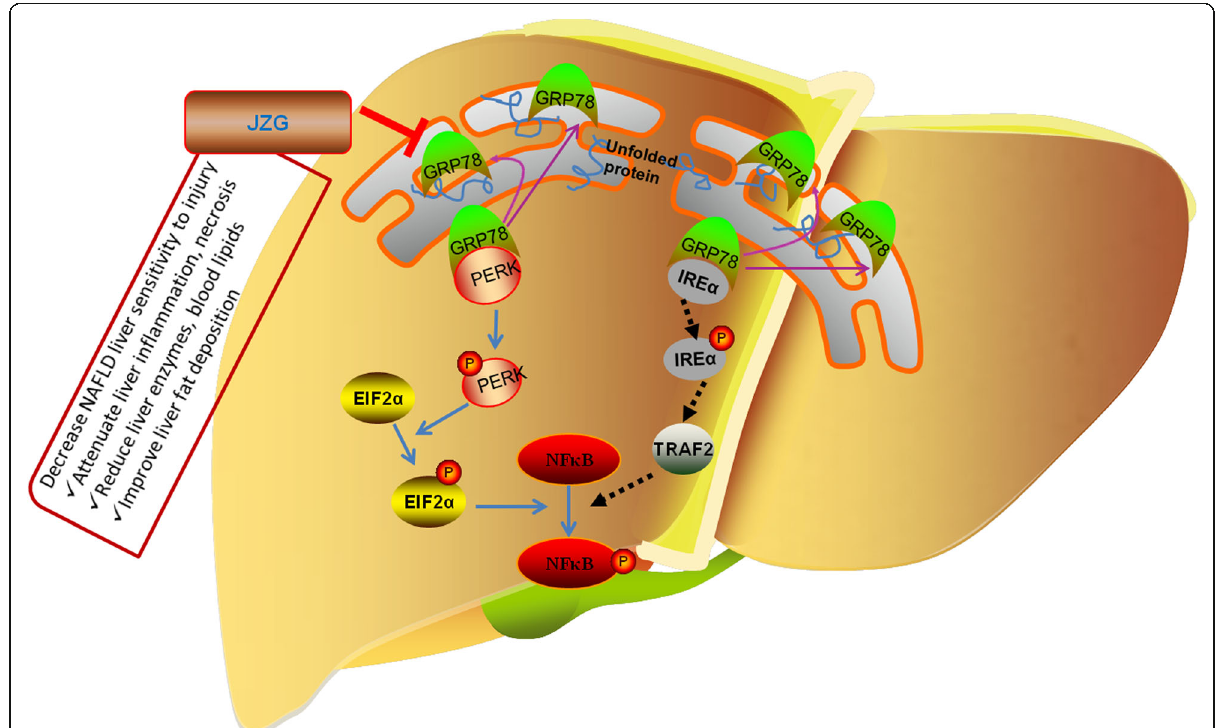
Fig. 8 The schematic for JZG decreasing the sensitivity of NAFLD to liver injury. The schematic of proposed function mechanism for JZG was drew according to the results of this study. Various stimuli induce the accumulation of unfolded proteins in the ER and up-regulate the expression of GRP78 to improve the situation. However, the binding of GRP78 with unfolded proteins results in its dissociation with PERK and IRE1, causing the activation of these proteins and triggering ERS. PERK is activated by autophosphorylation and then phosphorylate EIF2 α which promote the activation of NF κ B. The activation of IRE1 α could also mediate the further activation of NF к B through TRAF2. JZG could decrease the sensitivity of NAFLD to liver injury in rat through regulating ERS signaling pathway GRP78/PERK/EIF2 α /NF κ B, however, JZG did not affect the IRE1/ TRAF/ NF κ B